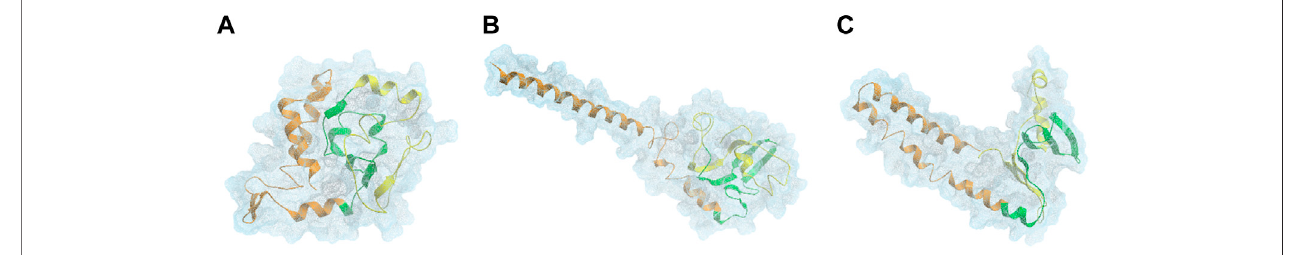
FIGURE 2 | DMD centroids of the most frequent monomeric WT α Syn lowest energy clusters. Clusters representing a (A) ∼ 76%, (B) 15%, and (C) ∼ 4% of the overall population. α Syn N-terminal region (residues 1 – 60) is colored in orange, the NAC-region (residues 61 – 95) is colored in green and the C-terminal region (residues 96 – 140) is colored in yellow (Zhang et al., 2018).